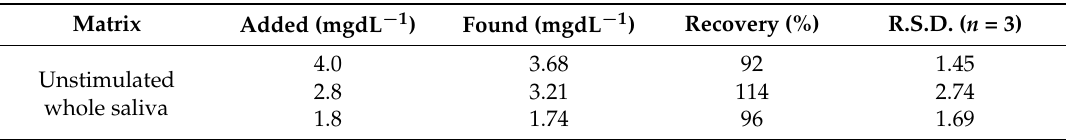
Table 2. Results for glucose determination in real